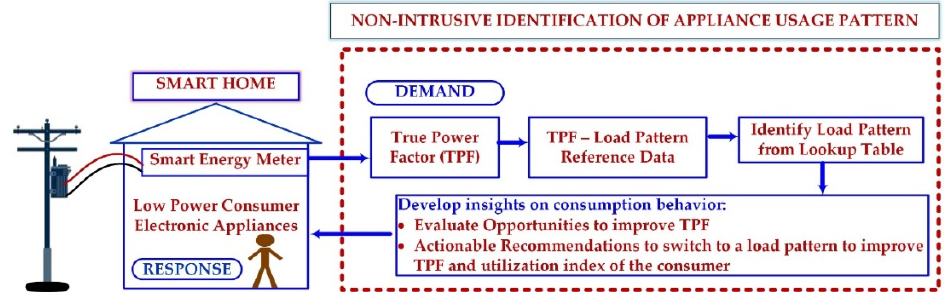
Figure 1. Schematic of demand-side management with the non-intrusive identification of appliance usage patterns in smart homes with the TPF.